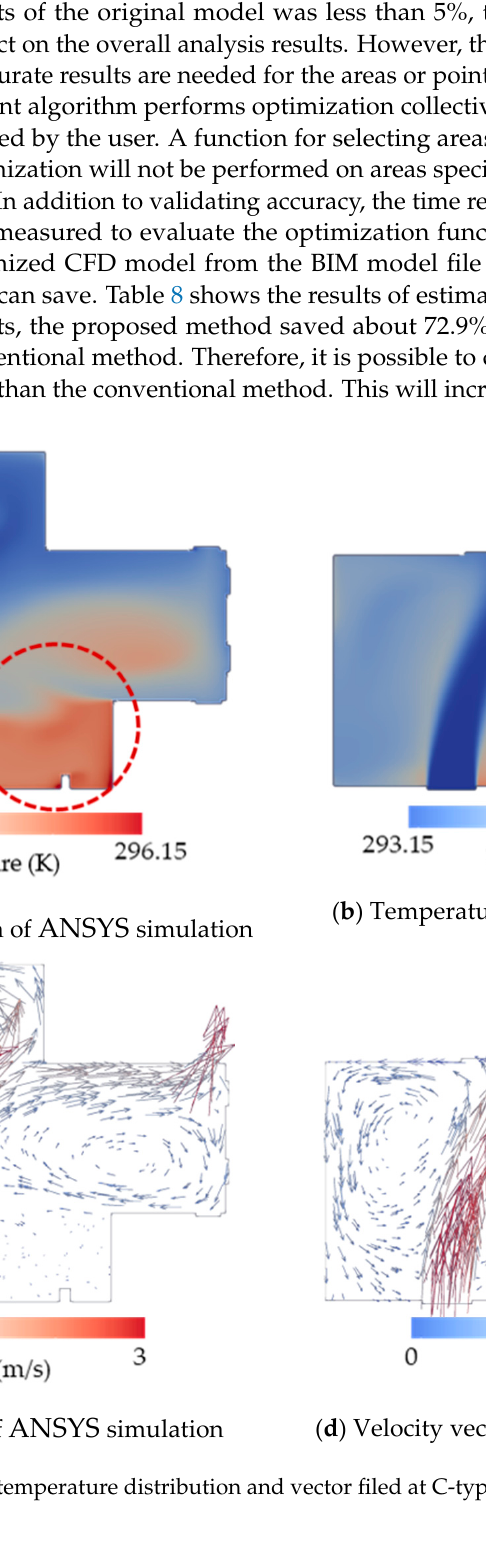
Table 7. Validation result for average temperature.